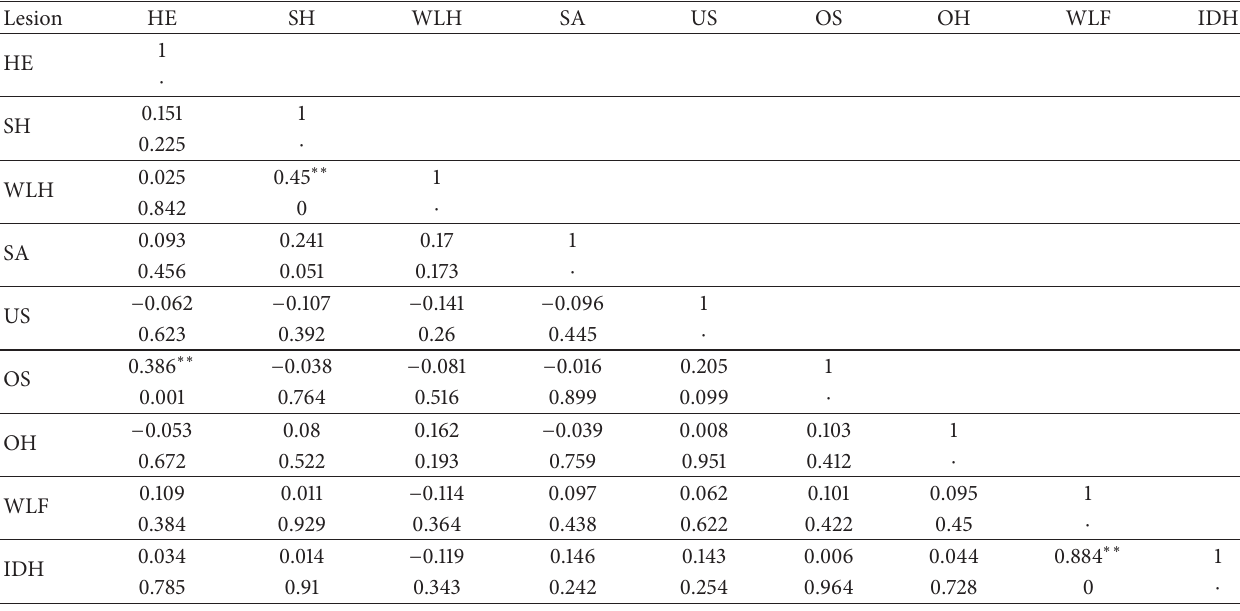
Table 4: Correlation between lesions within cows having locomotion scores 0 and 1 (first row = correlation coefficient, second row = probability